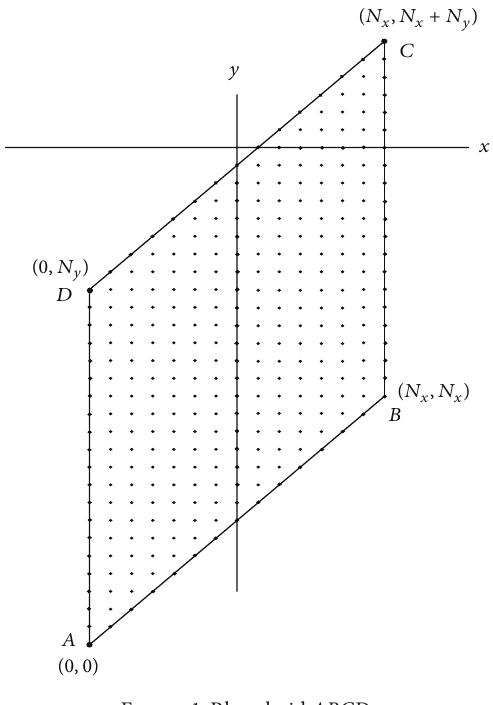
Figure 1: Rhomboid ABCD